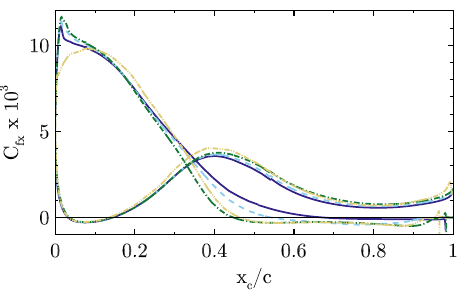
Figure 18. Airfoil skin friction distribution at r/R = 0 . 136 for CaseT1.0 (solid), CaseT1.2 (dashed), CaseT1.4 (dashed dot) and CaseT1.4-twistmod (dashed dot